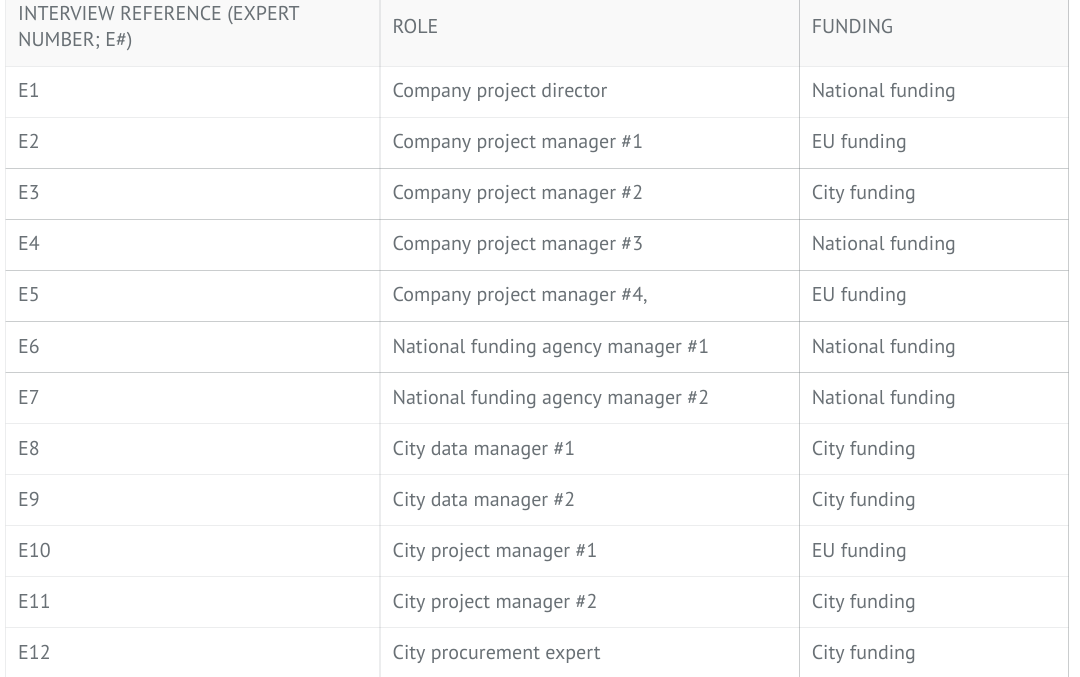
TABLE 1: Interviewees (pseudonymised) and funding instrument INTERVIEW REFERENCE